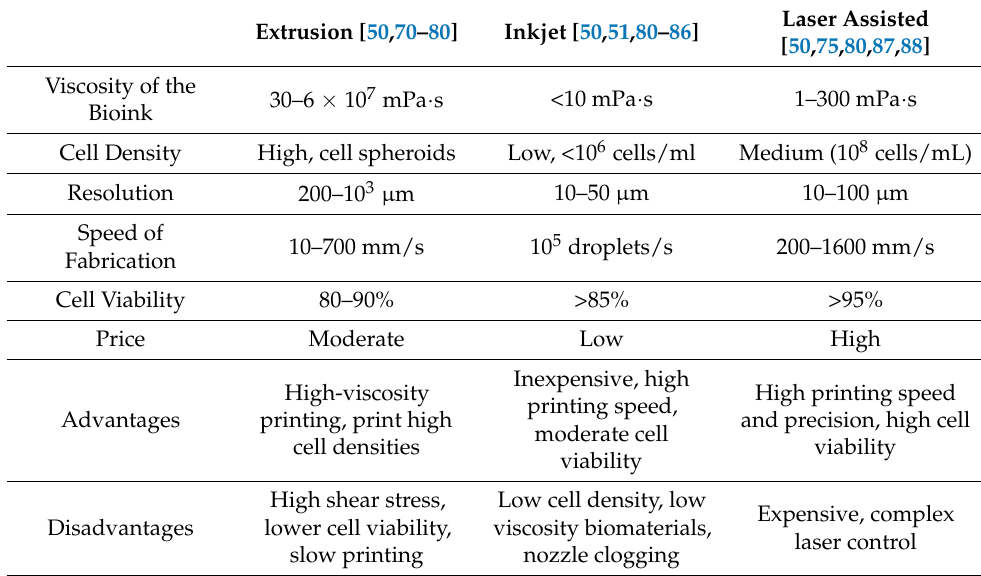
Table 1. Bioprinting